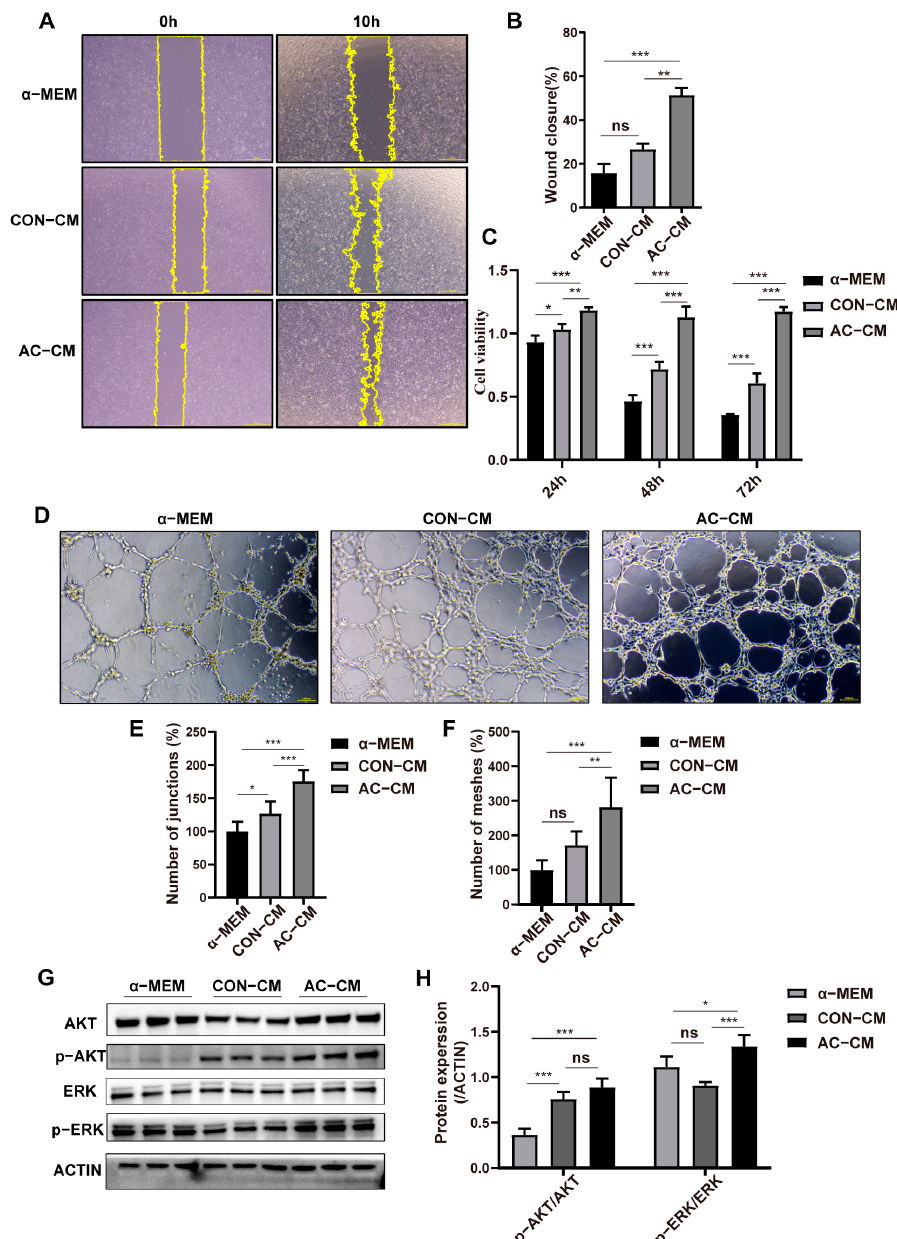
Figure 4. Conditioned medium from AC − ADSCs promotes endothelial function. ( A ) Representative scratch test image of HUVECs incubated with conditioned medium of CON − ADSCs and AC − ADSCs at 0 and 10 h, and ( B ) Rate of wound area closure after 10 h (%) ( n = 6, scale bar = 100 μ m). ( C ) CCK8 assay was used to evaluate the viability of HUVECs incubated with conditioned medium of CON − ADSCs and AC − ADSCs ( n = 6), and the statistical analysis of HUVECs viability within 72 h (%). ( D ) Representative tube formation images of HUVECs incubated with conditioned medium of CON − ADSCs and AC − ADSCs for 8 h ( n = 3, scale bar = 100 μ m), and ( E ) quantitative analysis of number of junctions, ( F ) number of meshes and per field. ( G ) Representative images of western blotting and ( H ) quantification analysis of ERK and AKT signaling pathways proteins expression in HUVECs incubated with conditioned medium of CON − ADSCs and AC − ADSCs ( n = 3). Data are shown as mean ± SD. Independent–sample t test (two-tailed) was used for statistical comparisons between 2 groups; One-way ANOVA followed by Tukey post hoc test was used for statistical comparisons between multiple groups. * p < 0.05; * * p < 0.01; ** * p <